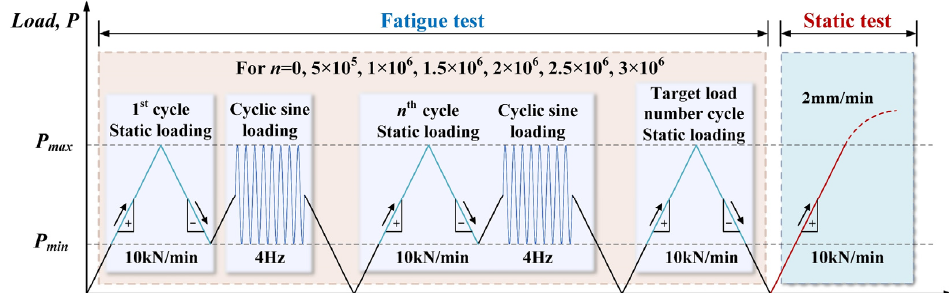
Figure 5. Loading procedure for the fatigue tests.